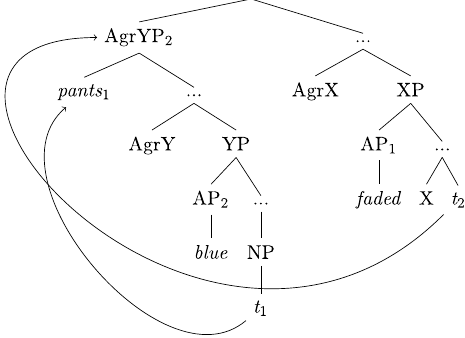
c. blue faded” c. Spanish Mirror Image Order: N Adj2 Adj1 pantalones desteñidos azules “pants blue faded”